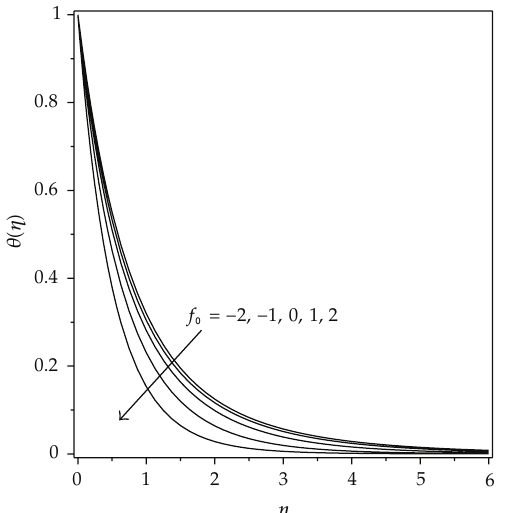
Figure 4: Temperature profiles for di ff erent values of f 0 when Pr (cid:9) 0 . 78, Sc (cid:9) 0 . 6, D f (cid:9) 0 . 03, S r (cid:9) 2, r (cid:9) 0, and M (cid:9)